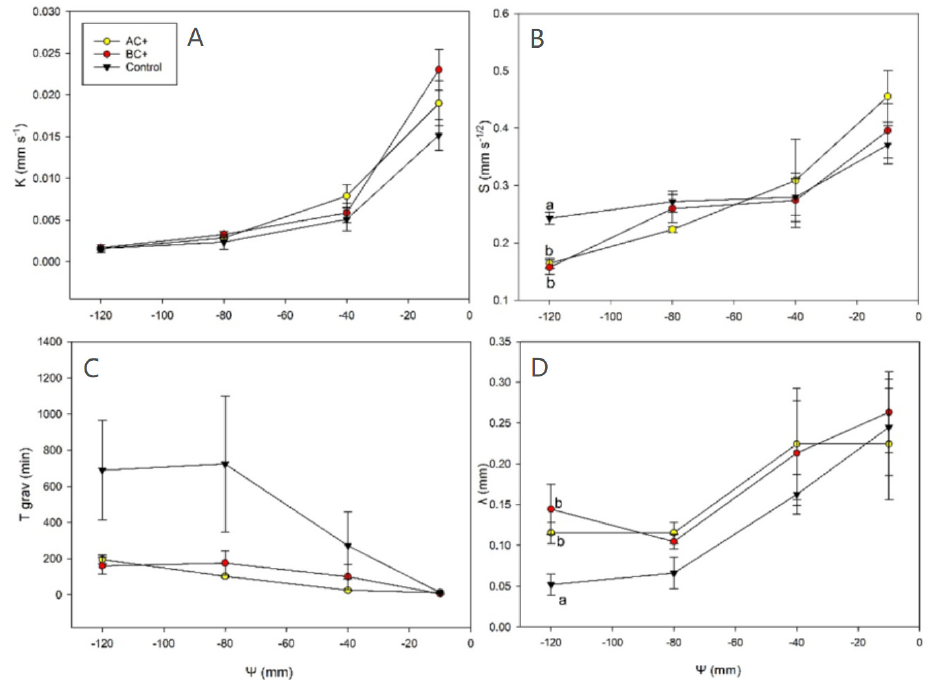
Figure 2. ( A ) Hydraulic conductivity (K), ( B ) sorptivity (S), ( C ) gravimetric time (T grav) and ( D ) frame-weighted mean pore size ( λ m) at different potential under different treatments: AC (alperujo compost), AC+ (high dose of alperujo compost), BC (biosolid compost), BC+ (high dose of biosolid compost). The same lowercase letters indicate no significant difference ( p > 0.05) between treatments within each year. Data are mean values ± standard error of the mean (SEM).